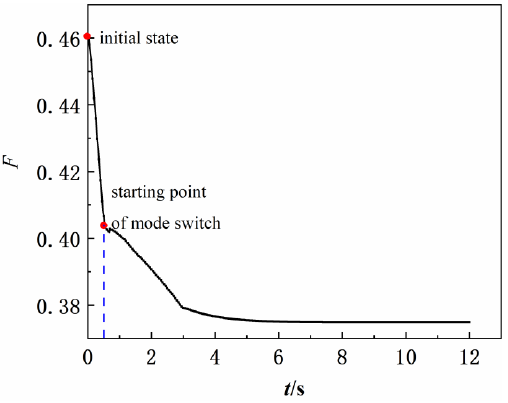
Figure 20. Change curve of thrust of working-mode switching from single bypass to double bypass at H = 11 km, Ma = 1.2.